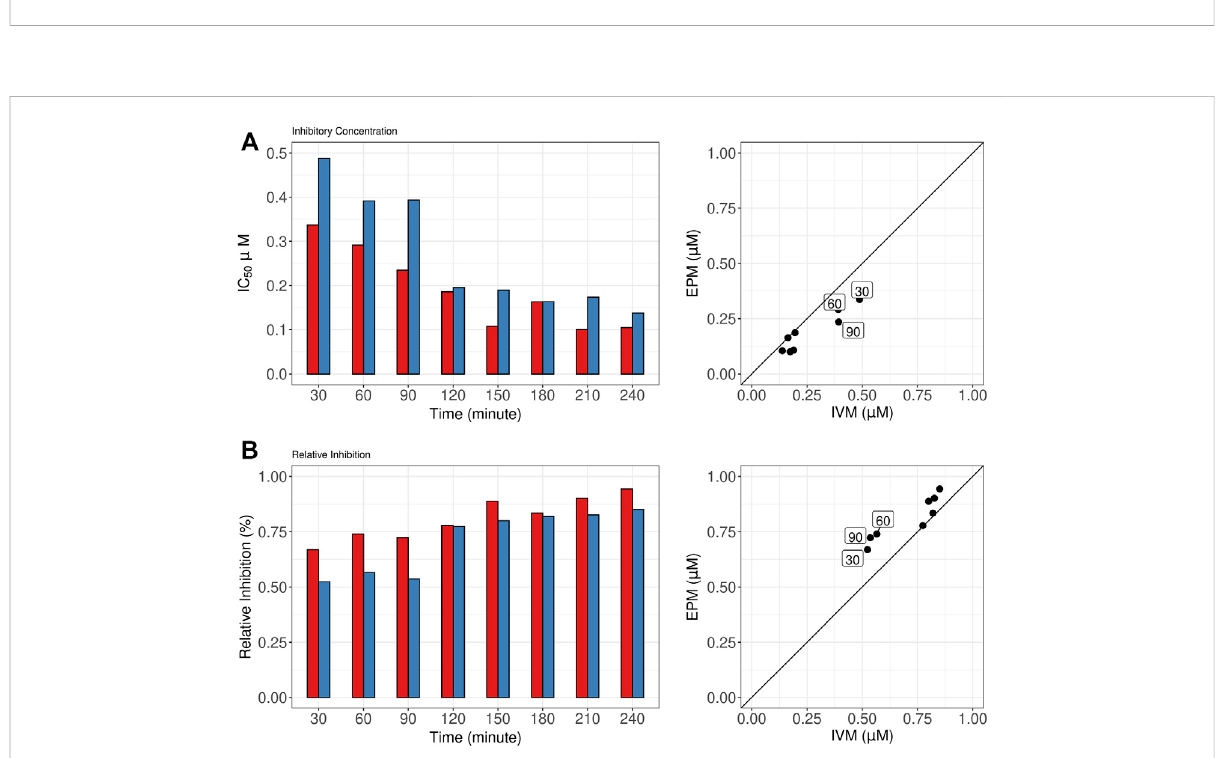
FIGURE 3 Half-maximalinhibitoryconcentration(IC50)andrelativeinhibition(RI)forsingledrugs . (A) .Eprinomectin(EPM)andIvermectin(IVM)IC50(left) andIC50EPM/IVMratios(right).30 – 240 minexposuretimes areshown (B) .EPMandIVMRI(left)andEPM/IVMRIratios.30 – 240 minexposuretime are shown. The squares highlight the higher potency of EPM than IVM at 30, 60, and 90